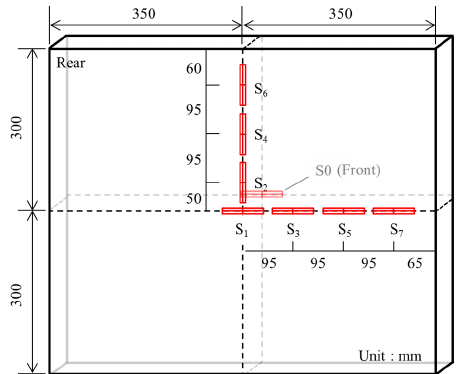
Figure 6. Measurement of fracture depth and crater diameter. ( a ) Failure mode and fracture depth; ( b ) Crater diameter.